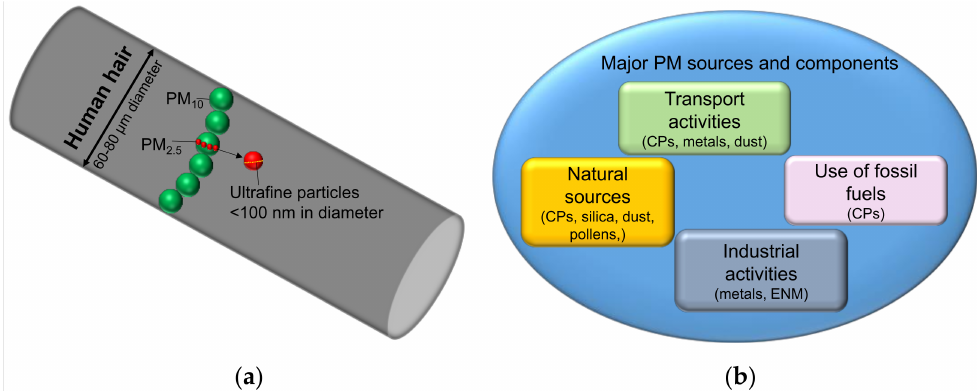
Figure 1. ( a ) Different components of PM based on size: PM 10 , PM 2.5 and PM 0.1 . With a decrease in the size of PM components, their concentration increases exponentially. ( b ) Major sources of PM pollution and different components from major